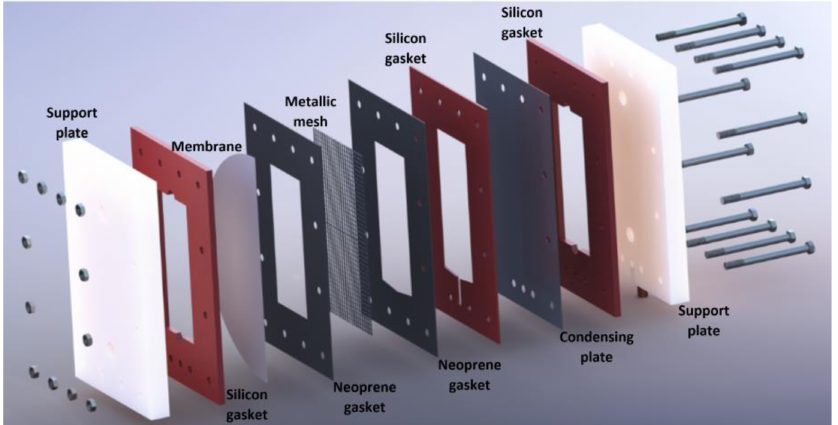
Figure 2. Exploded view of the experimental membrane-based